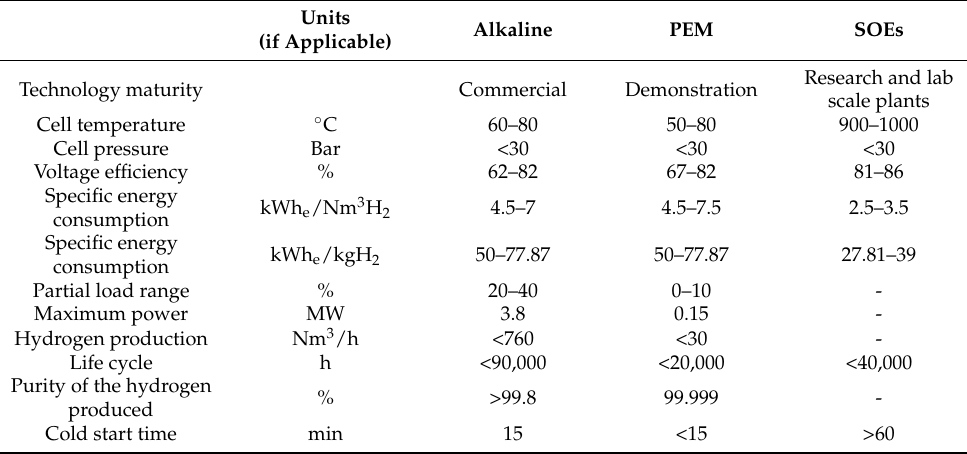
Table 3. Electrolyzers for Hydrogen production, adapted from [19]. Units (if Applicable)